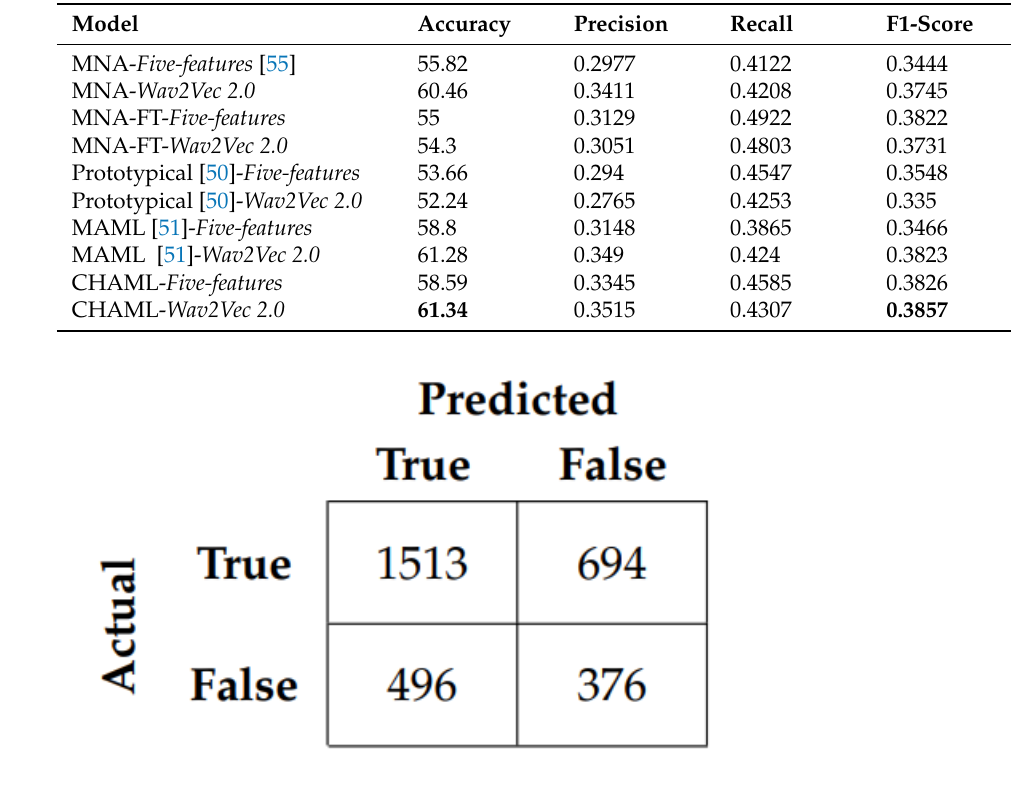
Table 5. Comparison of models performance.